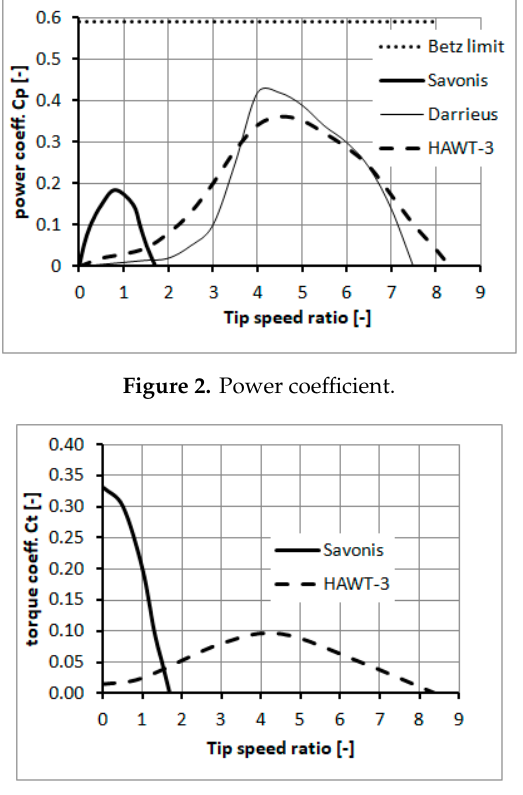
Figure 3. Rotor moment coefficient.